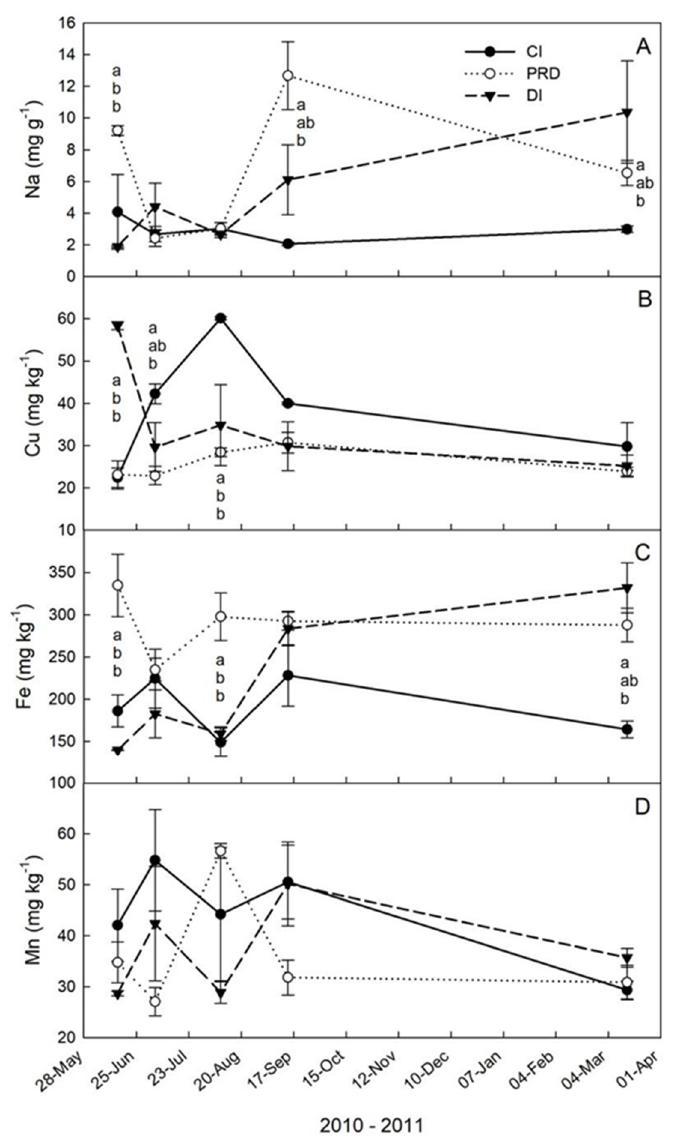
Figure 7. Sodium ( A ), cupper ( B ), iron ( C ), and manganese ( D ) content in leaves of adult ‘Valencia’ orange trees under conventional irrigation (CI), partial rootzone drying (PRD), and continuous deficit irrigation (DI) in the 2010–2011 cropping season. Error bars are standard errors of the means. Different letters indicate significant differences by Tukey’s multiple range test ( p < 0.05).